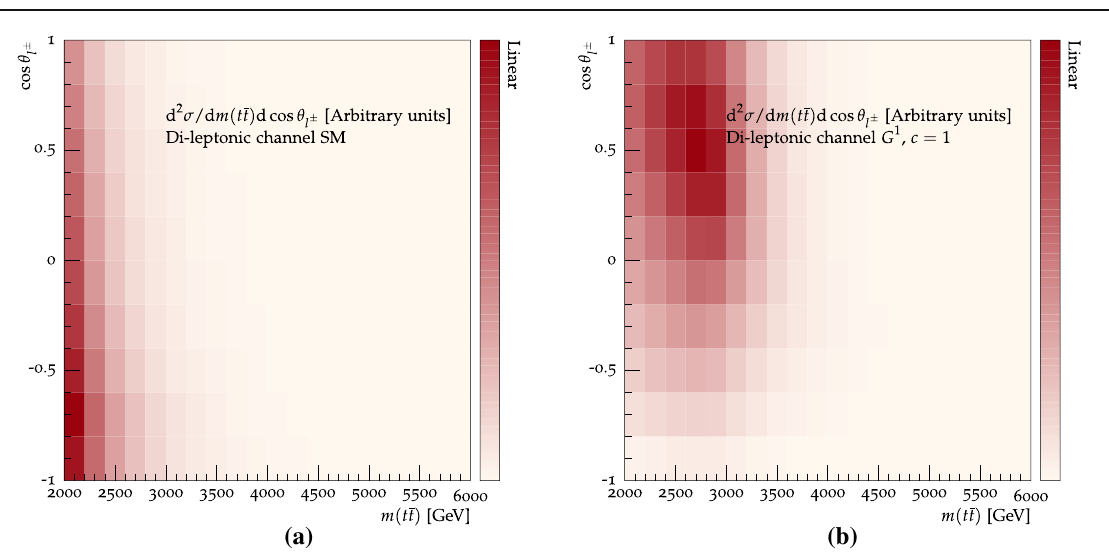
our signal models from the perspective of gaining additional informa- tion from the polarisation measurement